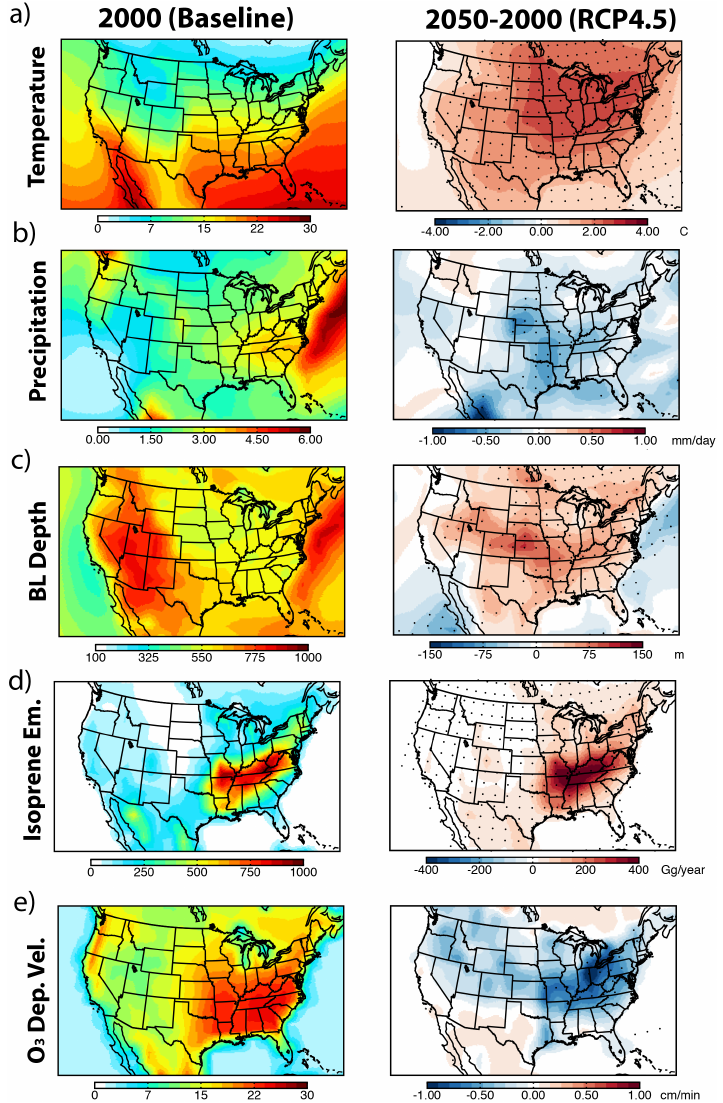
Figure 5. Simulated annual average present-day (left) and projected 2050–2000 changes (right) for surface temperature (a) , precipitation (b) , boundary layer depth (c) , isoprene emissions (d) and O 3 dry deposition velocity (e) . All maps show changes predicted by the RCP4.5 as a result of the combination of climate, land use and emission changes, except for the O 3 dry deposition velocity that shows only the changes from land use. Regions with changes that are significant at the 95% confidence level are indicated in the maps with dots, and maps show interpolated contours from the 1.9 × 2.5 ◦ horizontal resolution